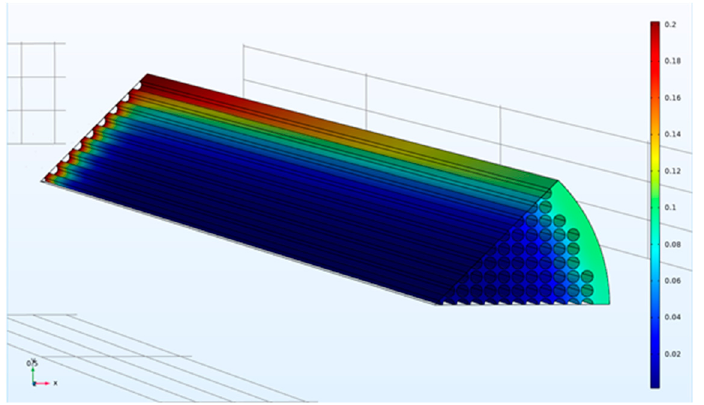
Figure 9. Simulation geometry and sample CO 2 mole fraction distribution for circular bundle with square configuration ( ɸ = 0 .6, D/R f = 3). Concentration decreases from red to blue.